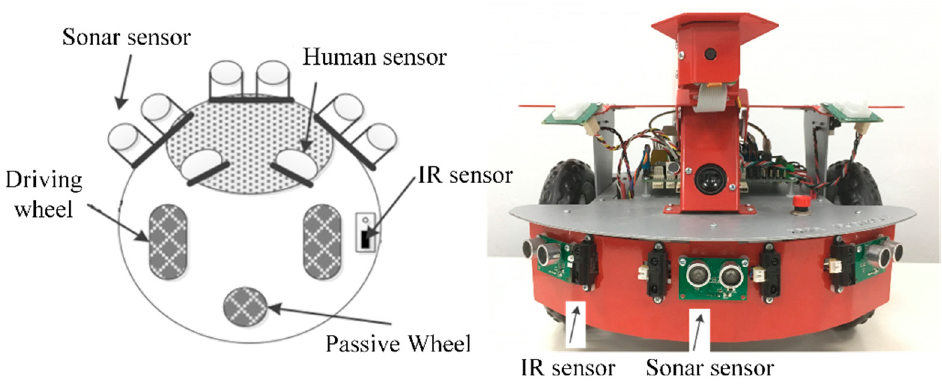
Figure 1. The outline of the circular non-holonomic mobile robot Dr. Robot X80 used for the